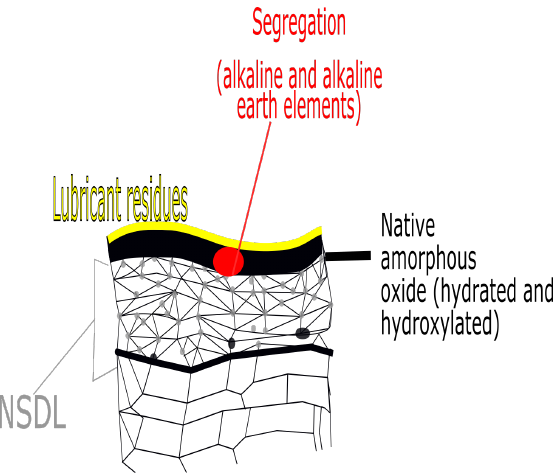
Figure 8. Main features of the aluminium top surface after rolling. NSDL is the near surface deformed layer which is created after the rolling